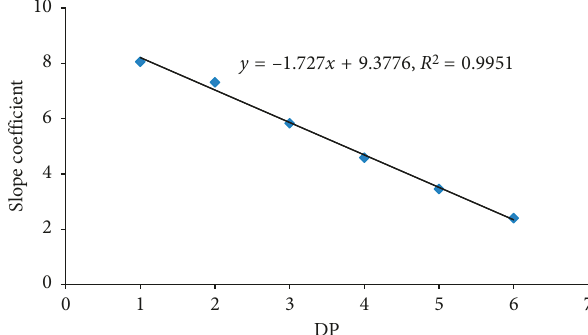
Figure 4: Linear relationship between the slope coefficient of each COS’s regression equation and the corresponding